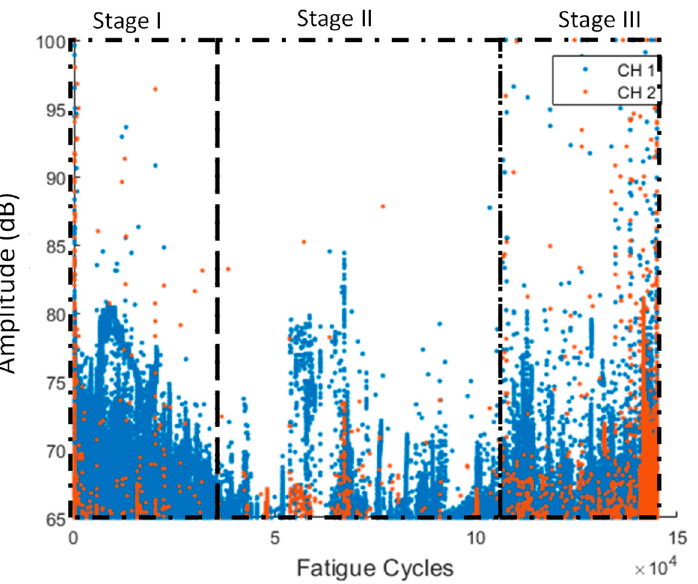
Figure 11. Amplitude vs. fatigue cycles for all the different AE channels for specimen CA-2 (stages are qualitatively drawn).